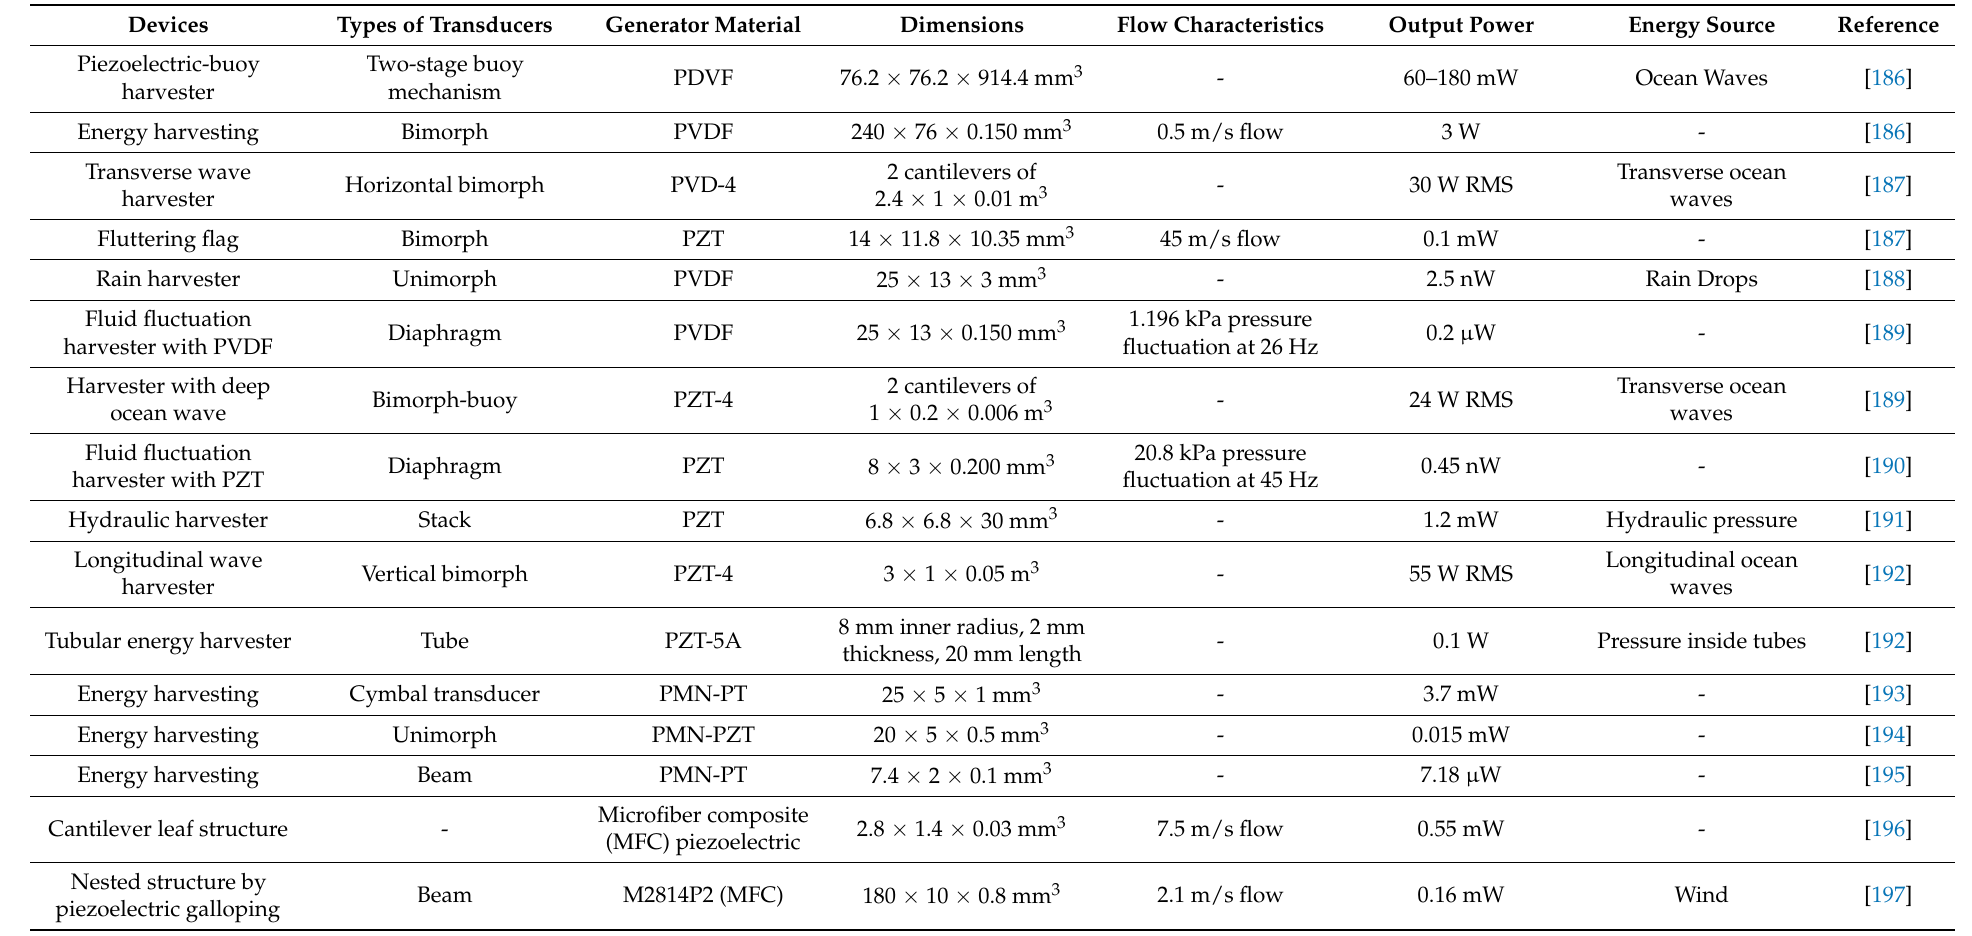
Table 3. Piezoelectric Devices for Liquid-Fluid-Energy